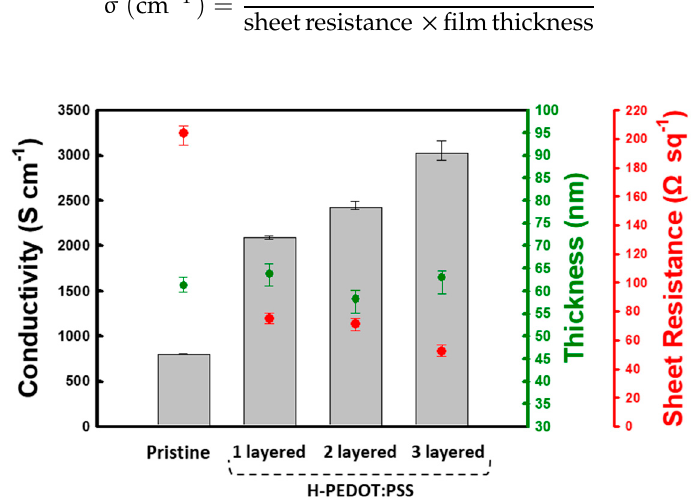
Figure 1. The comparison data of sheet resistance (red color), film thickness (green color) and electrical conductivity of pristine PEDOT:PSS and H-PEDOT:PSS thin films according to an H 2 SO 4 / DMSO treatment and an layer-by-layer (LBL) process. The thickness of each sample was experimentally optimized at the same thickness (about 60 nm).